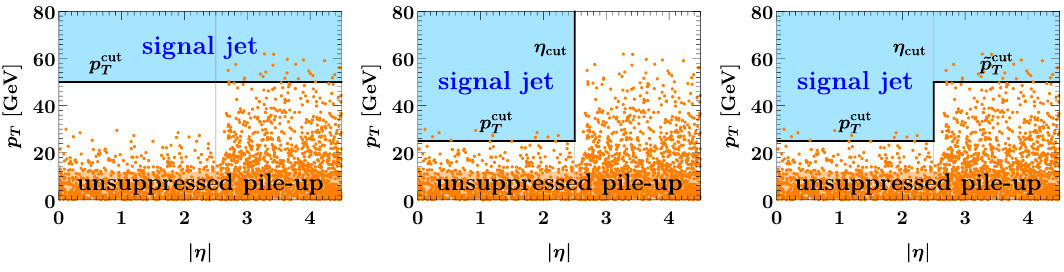
Figure 1 . Cartoon of possible strategies to avoid contamination from unsuppressed pile up in jet-binned analyses. The pile-up suppression is much better in the pseudorapidity range where it can use information from the tracking detectors. To avoid the higher pile-up contamination in the forward region, one can raise the jet threshold (left panel), only consider central jets (middle panel), or combine both approaches by using a step-like jet selection (right